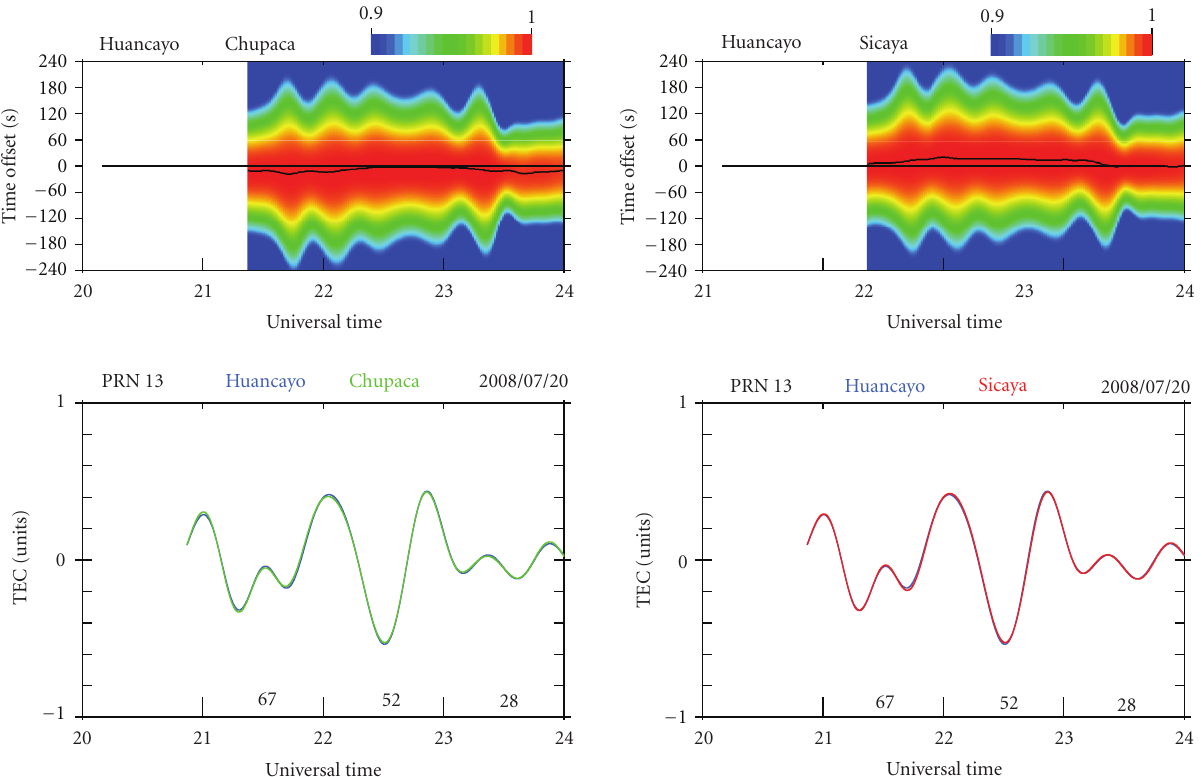
Figure 6: Cross-correlation functions (top panels) and TECP curves (lower frames) for GPS satellite 13. The left frames show the CCFs for TECP signals from Huancayo and Chupaca. The right panels correspond to Huancayo and Sicaya. The cross-correlation functions are plotted using a color scale that varies between 0.9 and 1.0. The black line that crosses near the middle corresponds to the maximum and it is taken as the time delay ( T B − A or T B − C ).